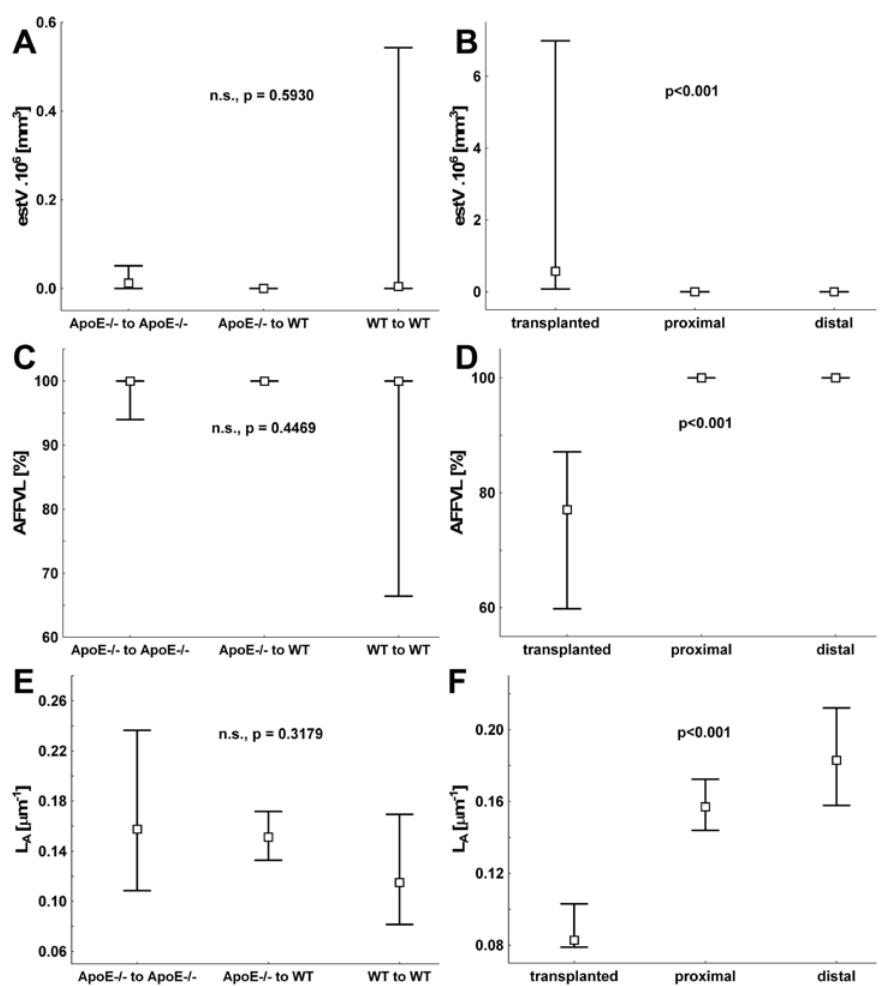
Figure 4. Quantitative analysis of aortae in the experimental groups and in samples taken from different sites. (A, B) Estimated volume of lesions ( estV ), (C, D) area fraction of the free vessel lumen ( AFFVL ), and (E, F) length density ( L ) of elastin fibres. Values are medians with 25-75 A percentiles, n=12 in Group 1 (ApoE-/- to ApoE-/-), n=13 in Group 2 (ApoE-/- to wild-type(WT)), n=13 in Group 3 (WT to WT), n=12 in transplanted , n=12 in proximal , n=13 in distal . P-values of Kruskal-Wallis ANOVA are presented, n.s. – non significant. Proximal and distal are non-transplanted aortic segments adjacent to the transplanted